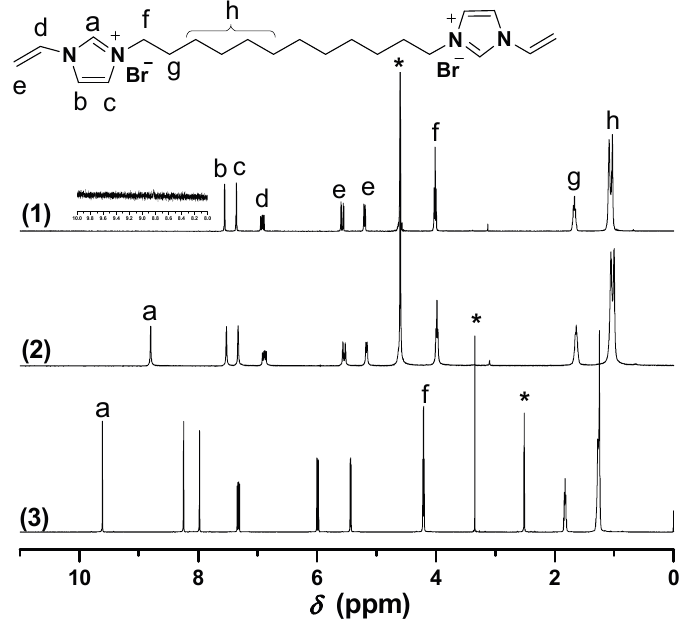
Figure 3. 1 H-NMR of [C 12 VIm]Br in different deuterium solvents. ((1) D 2 O, 30 min later; (2) D 2 O, immediately; (3) DMSO- d 6 ). * The peak is ascribed to the